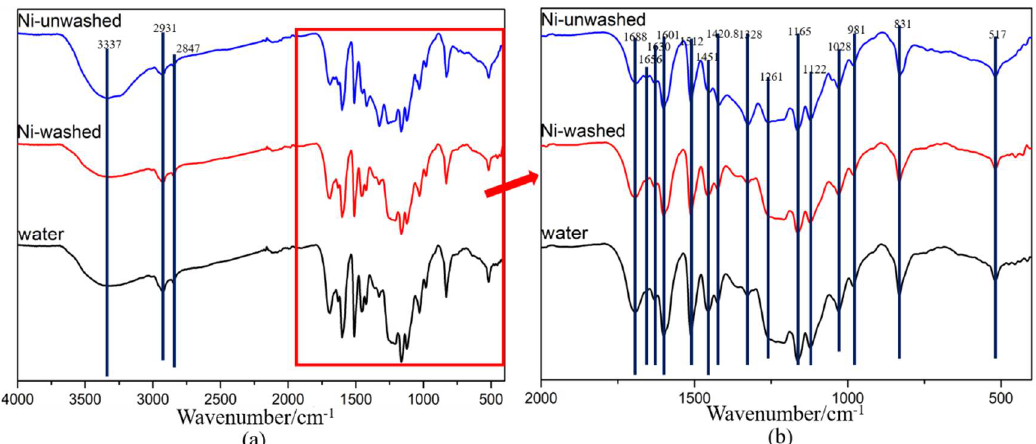
Figure 1. The FT-IR spectra of pretreated organsolv lignin in different ranges: ( a ) in the range of 4000–400 cm − 1 ; ( b ) in the range of 2000–400 cm − 1 .